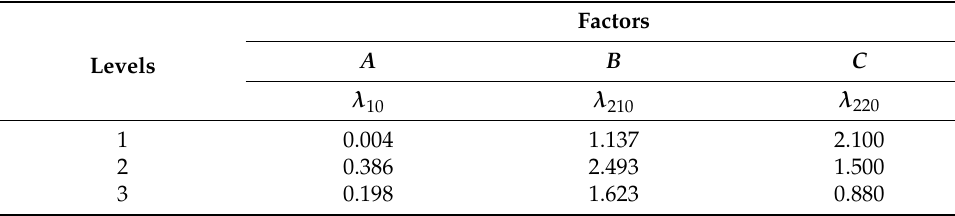
Table 2. Factors and levels of the orthogonal experiment.